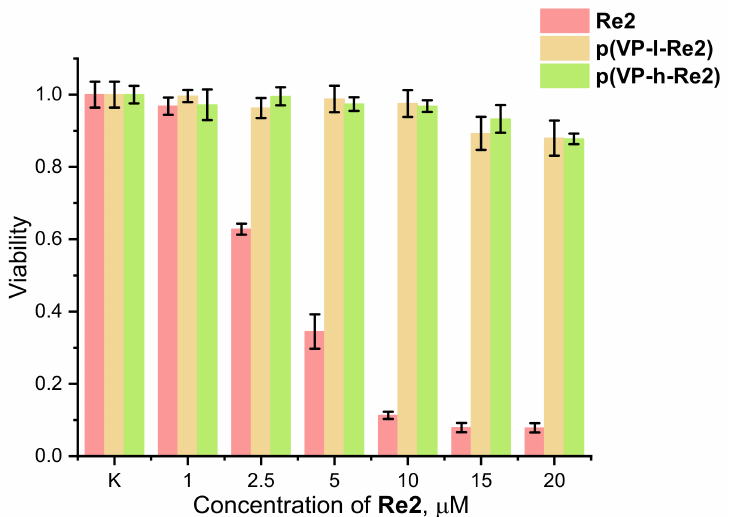
Figure 6. Viability of CHO-K1 cells after incubation for 24 h with Re2 and its copolymers determined by MTT assay. Cell viability of the control cells (without probes) was taken for 1. Mean ± standard deviation. N = 6